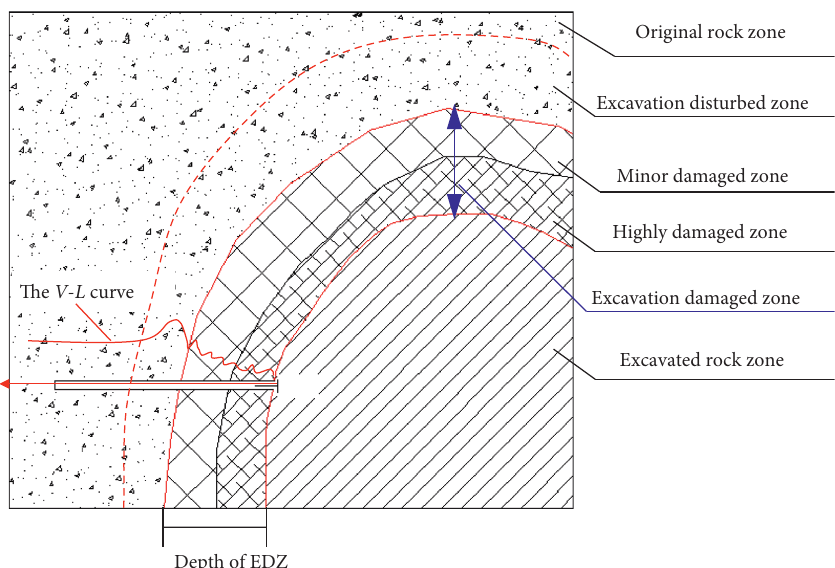
Figure 1: Principle of determining the depth of EDZ by acoustic testing.